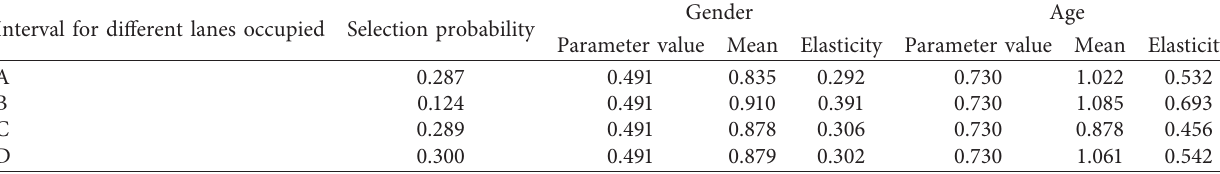
Table 9: Calculation results for age and gender.